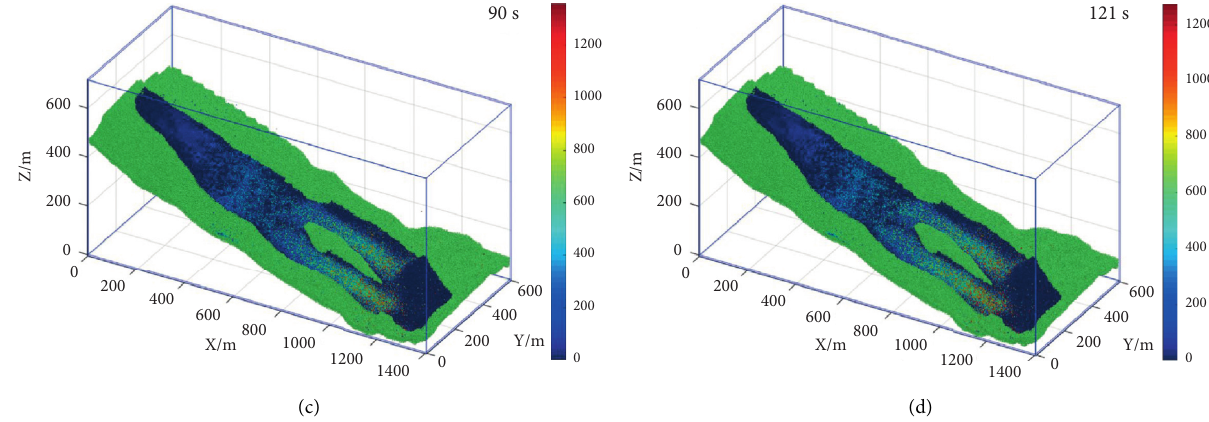
Figure 7: Change of displacement during the landslide movement. (a) 19s. (b) 44s. (c) 90s. (d) 121 s.